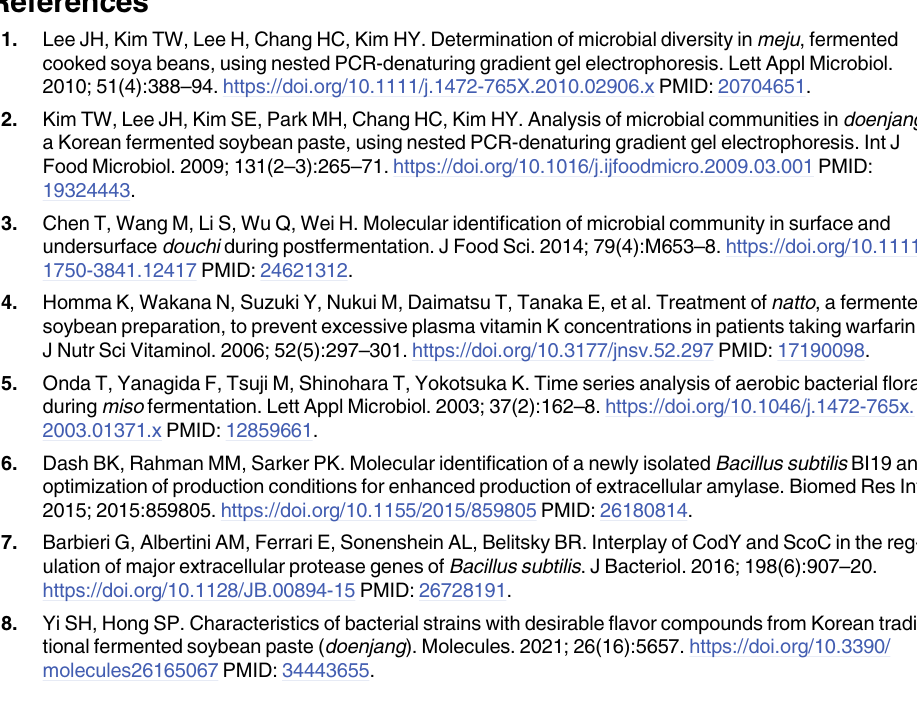
S1 Table. Bacterial strains and genome accession numbers. S2 Table. Sequence types of Bacillus subtilis using four MLST schemes, as well as the num- bers of alleles. S3 Table. Compositional characteristics of genes used in the four MLST schemes for B . subtilis